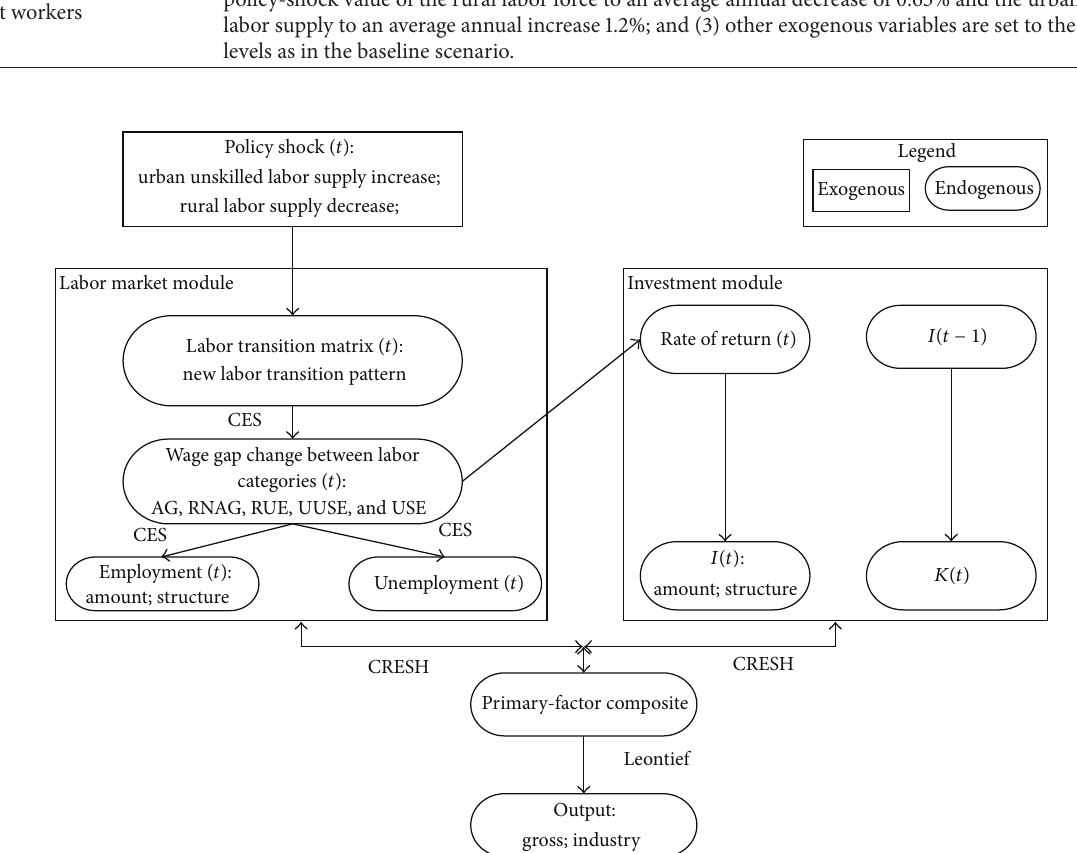
Figure 1: The transmission mechanism of the simulation